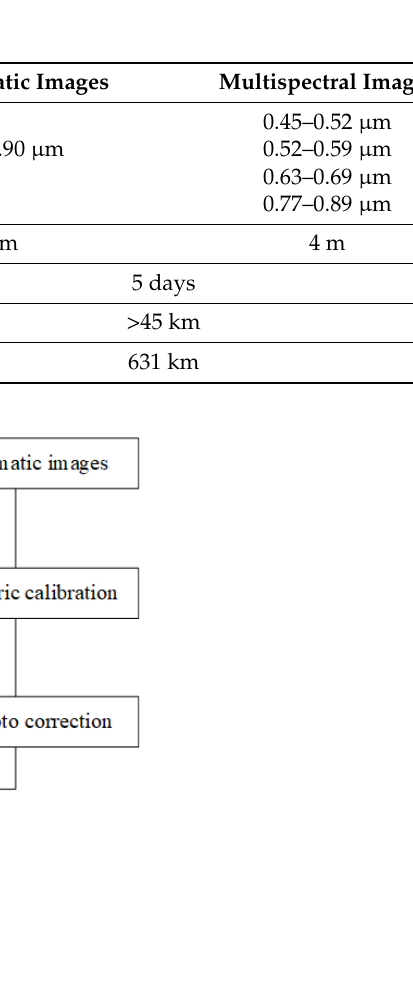
Figure 2. Workflow of satellite image